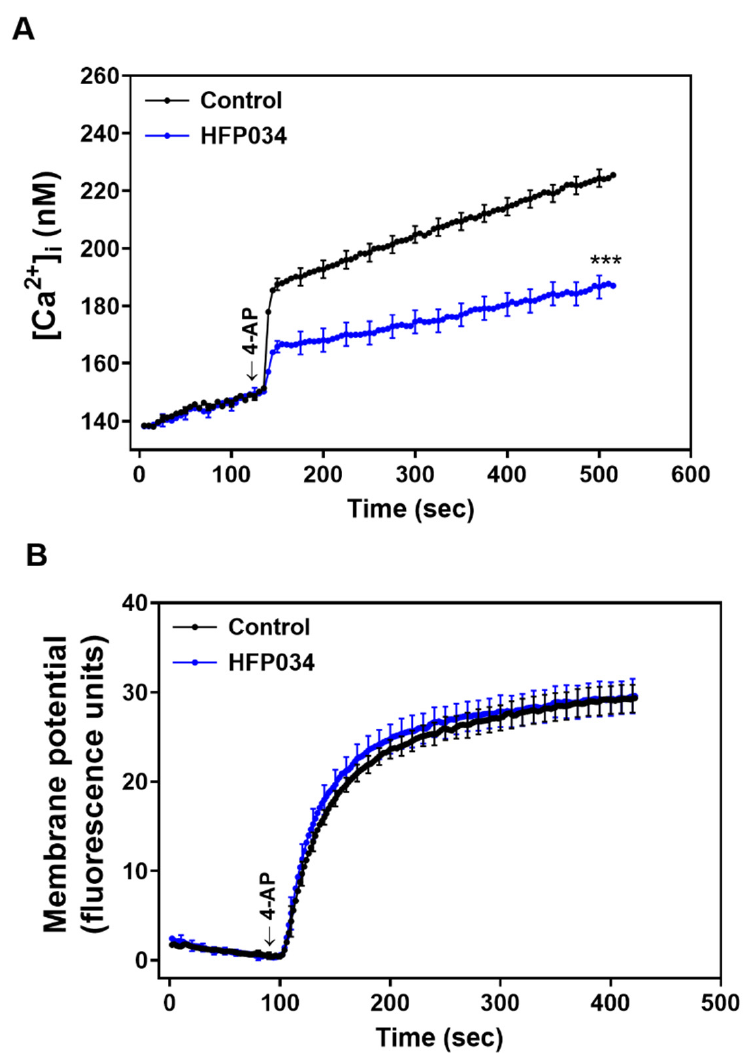
Figure 2. Effect of eupafolin on [Ca 2+ ] i ( A ) and the synaptosomal membrane potential ( B ). HFP034 (10 µ M) was added 10 min before the addition of 4-AP. Data are presented as mean ± S.E.M. ( n = 5 per group). *** p < 0.001, versus control group.